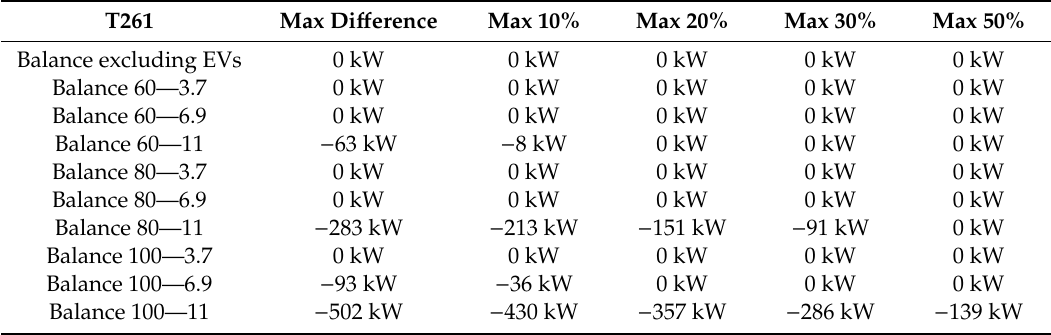
Table 15. Replacement of electric heating by district heating in the presence of flexible demand for transformer T261—Charging at night.